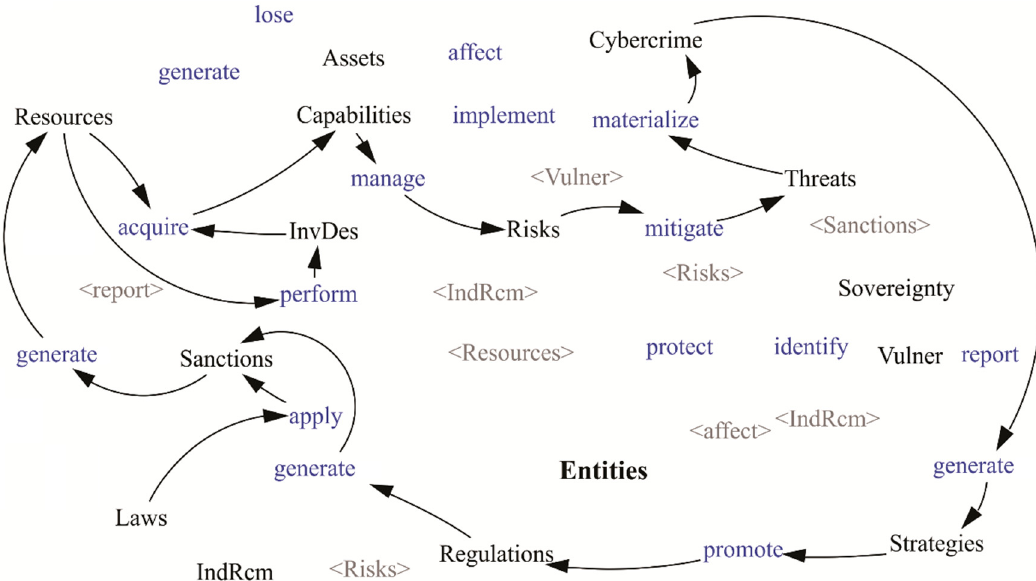
Figure 6. Cycle of crime by capabilities and laws.